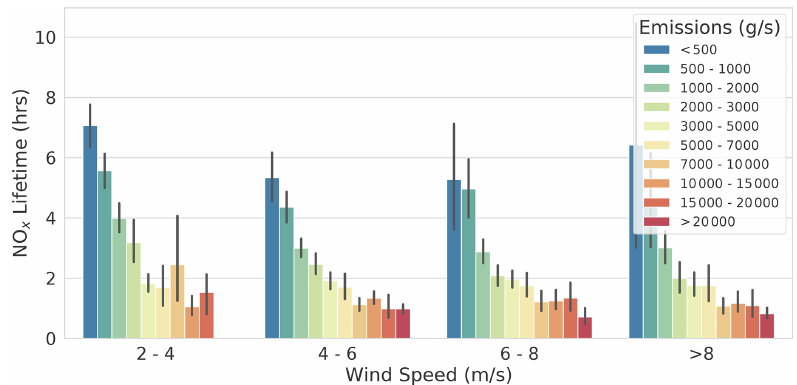
Figure 5. The mean and standard deviation of TROPOMI-derived NO x lifetimes from fires at different emissions (color) and wind speeds. Fire episodes with less than 2ms − 1 wind speed are not